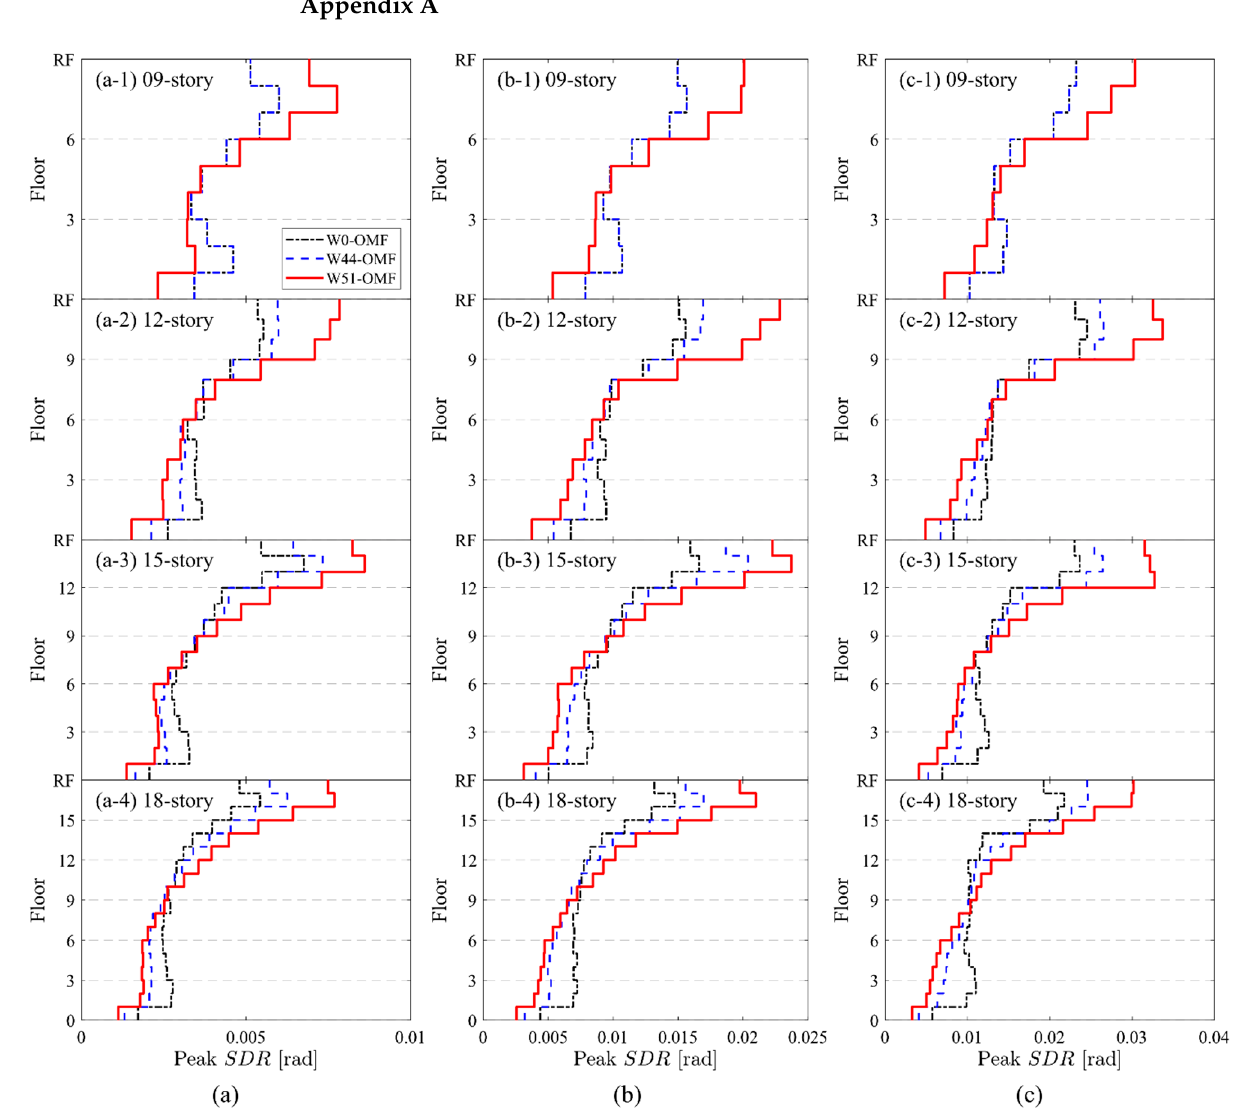
Figure A1. Peak story drift ratio ( 𝑆𝐷𝑅 ) for given specific intensity measure ( 𝑖𝑚 ): ( a ) Service level earthquake (SLE); ( b ) design-based earthquake (DBE); ( c ) maximum considered earthquake (MCE).